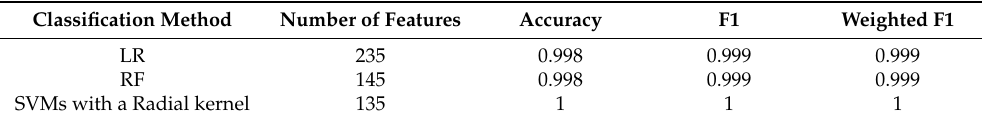
Table 9. The maximum values of the performance metrics (all classification combined with FastText